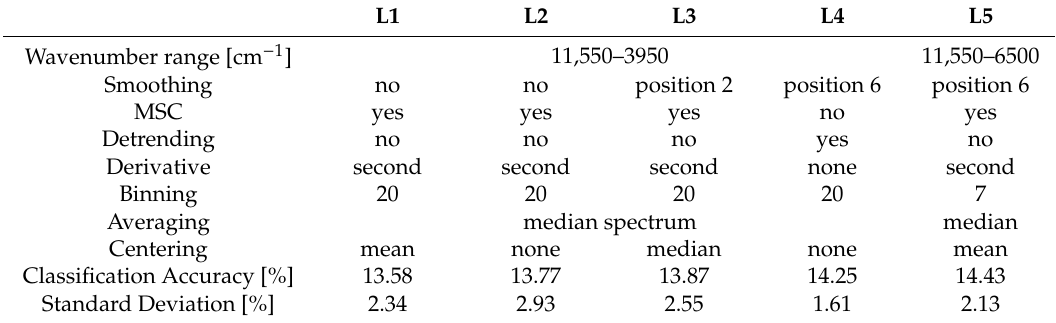
Table 3. Less suitable pre-processing strategies of all 50,545 combinations, based on linear discriminant analysis (LDA) in a 5-fold repetition of the nested cross-validation (cv) including 212 walnut samples. L1 L2 L3 L4 L5